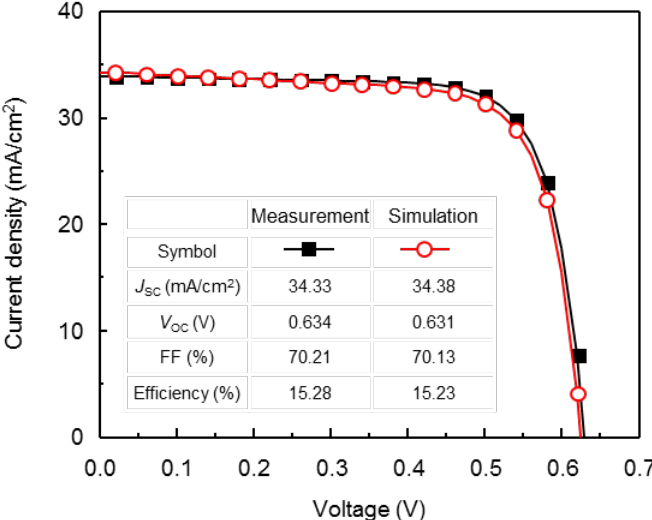
Figure 7. Light current density-voltage curves of the experimental results (solid symbol) and simulation results (open symbol).